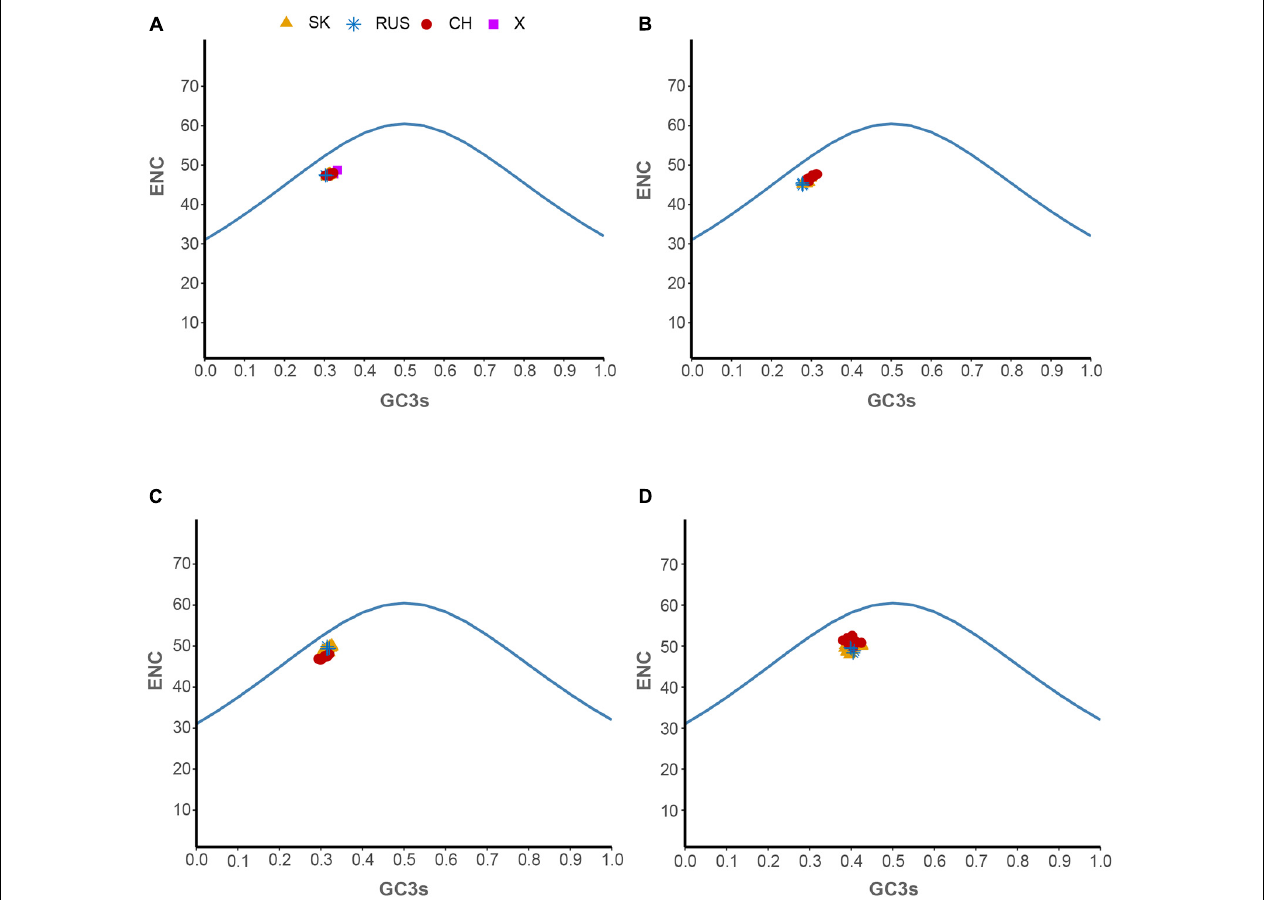
FIGURE 3 | ENC-plot analysis. (A) Overall genome, (B) L-segment, (C) M-segment, and (D) S-segment. The continuous blue curve represents the expected ENC if GC3 s composition solely constrains the codon usage bias. X represents isolates were regarded as out of three phylogenetic clades. The color coding is the same in all plots.